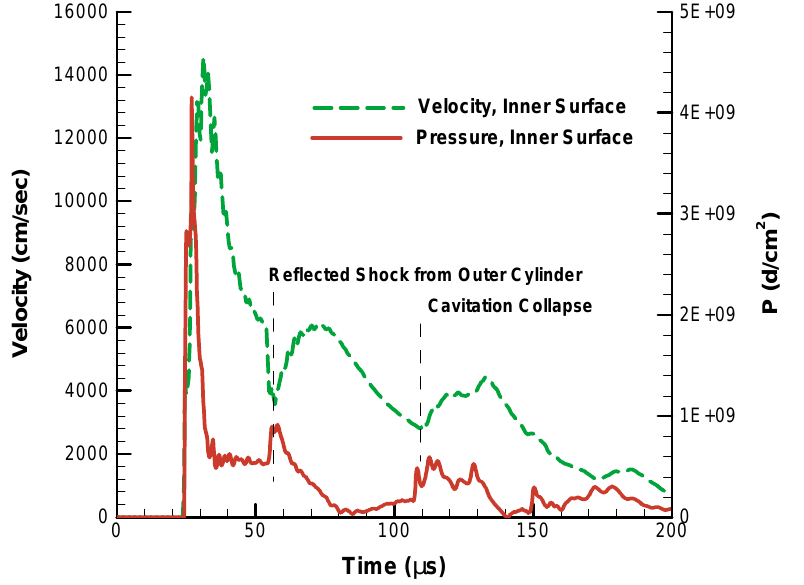
Fig. 16. Computed velocity of the inside of the inner wall at the midline for the double wall